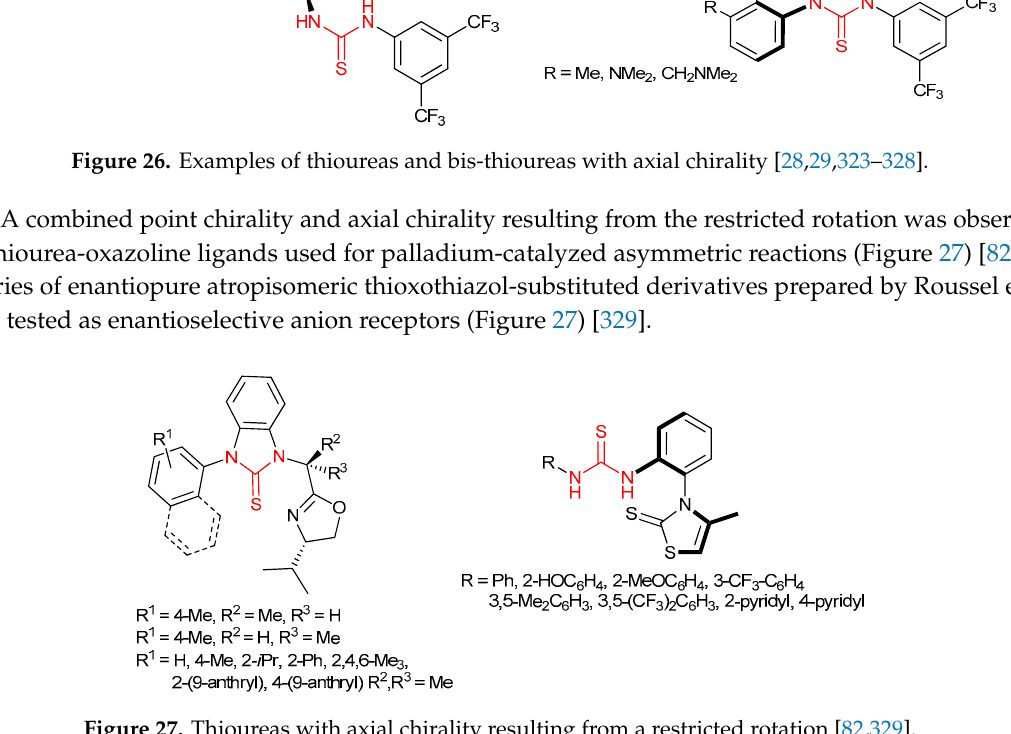
Figure 27. Thioureas with axial chirality resulting from a restricted rotation [82,329].